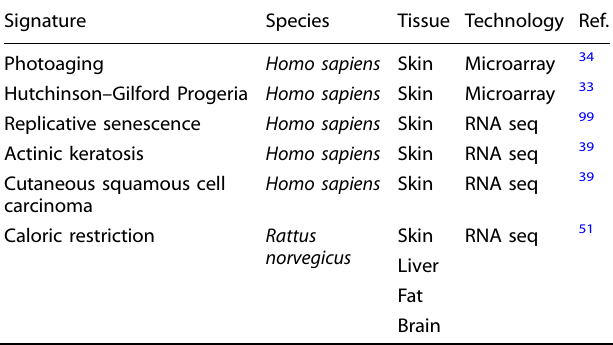
Table 3. Signatures used for perturbation